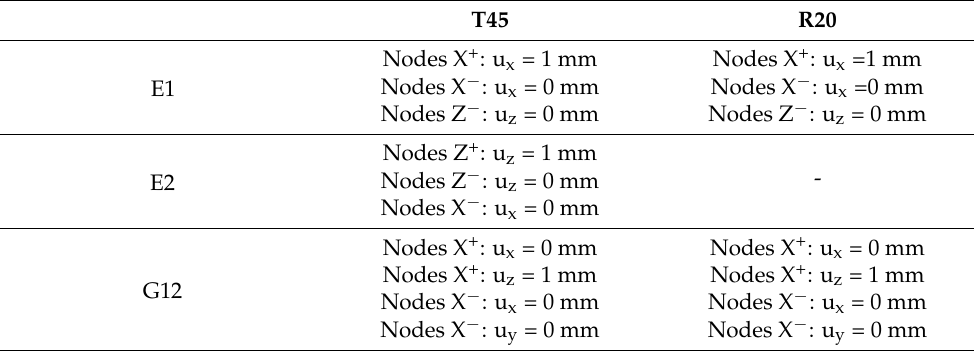
Table 4. Applied boundary conditions to the different simulations (u x , u y, and u z refer to displace- ments along X -axis, Y -axis, and Z -axis, respectively).